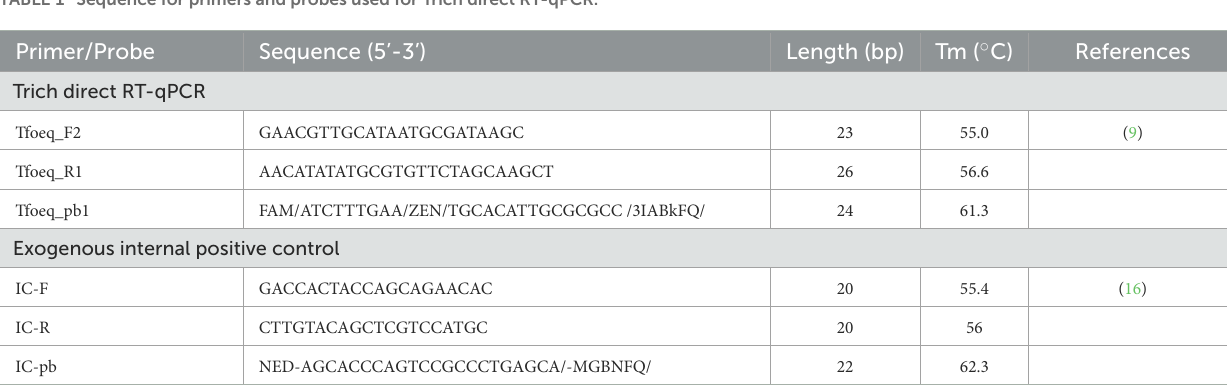
TABLE 1 Sequence for primers and probes used for Trich direct